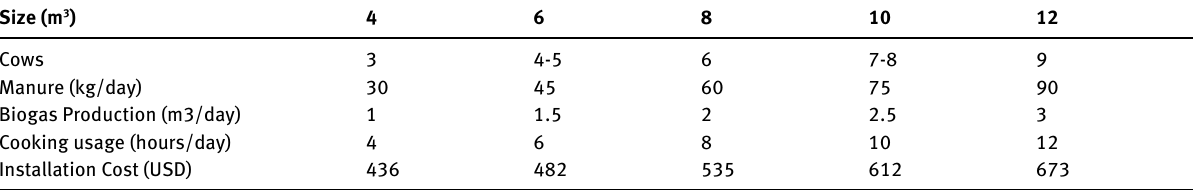
Table 7: Example of Range of Size, Capacity, and Cost of Biogas